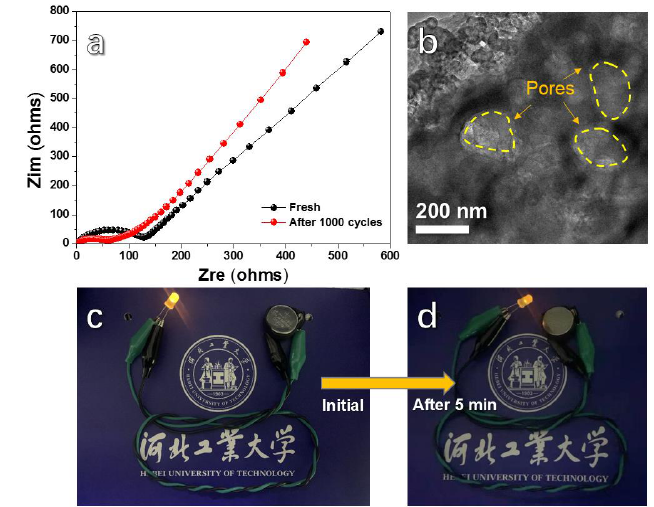
Figure 6. ( a ) Nyquist plots for HPC anode before and after 1000 cycles; ( b ) SEM image of HPC anode after cycling at 1000 mA g −1 for 1000 cycles; and digital photographs of a yellow LED bulb propelled by an HPC battery: ( c ) Initial and ( d ) after 5 min. Table 1. Comparison of electrochemical performances for various biomass-derived carbons as LIB anodes.